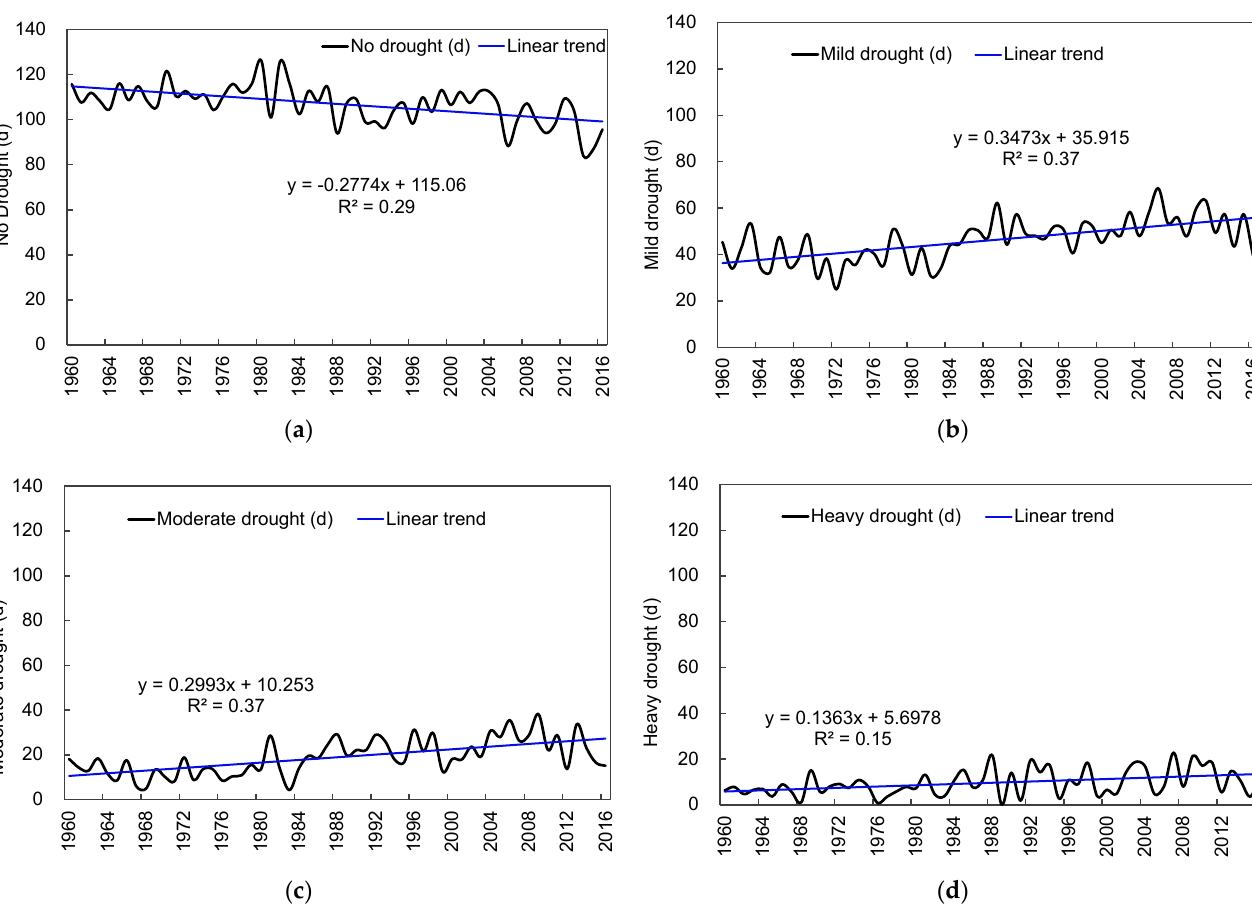
Figure 10. The temporal changes of ( a ) no drought, ( b ) mild drought, ( c ) moderate drought, ( d ) heavy drought. The spatial variations of the four levels of droughts were also obvious, as indicated in Figure 11. The no droughts were concentrated in the northern and central parts of Guizhou province. The mild droughts were in general uniform in the spatial domain, ranging from 30.6 to 57.9 d. The spatial distribution of moderate droughts and heavy droughts were similar, which were characterized by large Dnp values in southwestern (Wangmo, Luodian, and Rongjiang) Guizhou, and followed by the northeast (Tongren). The Dnp values of moderate and heavy droughts decreased from southeast to